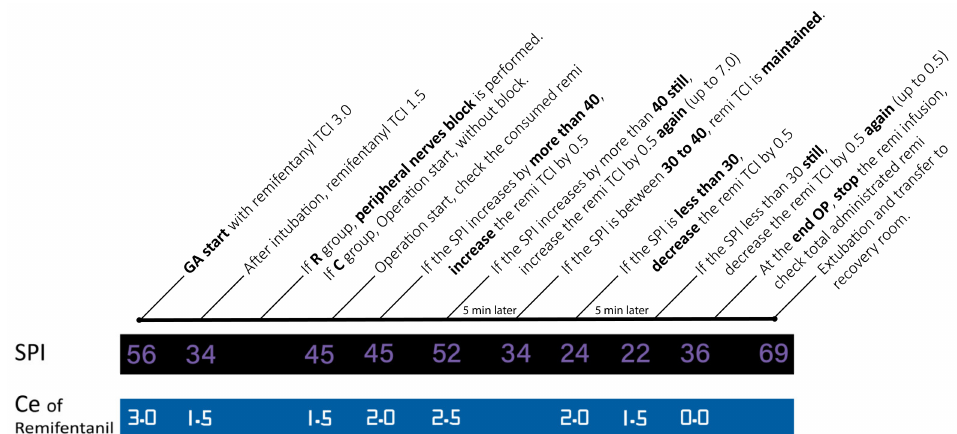
Figure 1. SPI-guided remifentanil infusion. Abbreviations are as follows: SPI, surgical pleth index; OP, operation; remi, remifentanil; TCI, target-controlled infusion; GA, general anesthesia; R, regional group; C, control group; Ce, concentration of effector